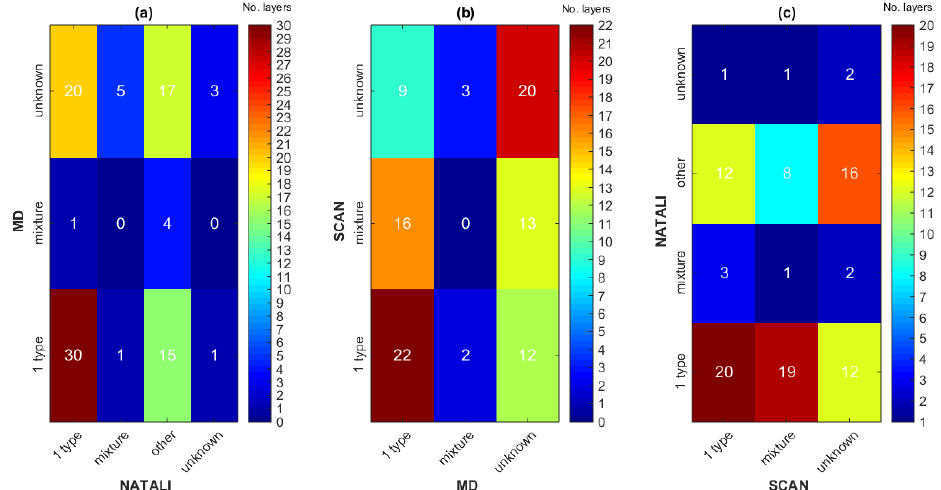
Figure 7. Comparison between classified aerosol layers by (a) NATALI and MD, (b) MD and SCAN, and (c) SCAN and NATALI. The number of classified aerosol layers as indicated by the i row and the j column is given inside each ( i,j )